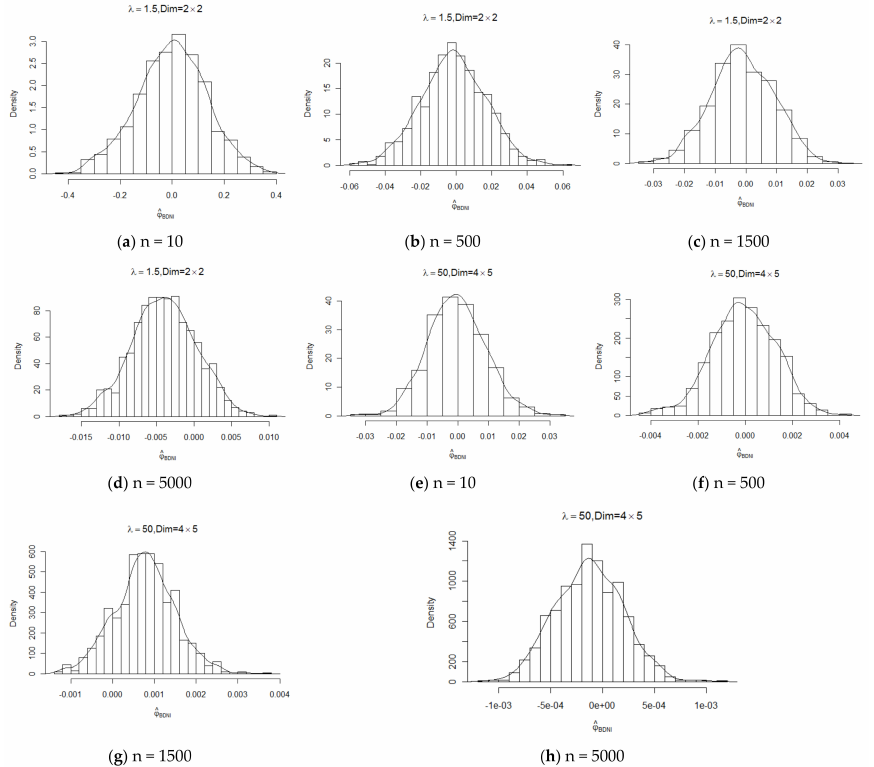
Figure 2. Graphical display of asymptotic distribution of ˆ ϕ BDNI